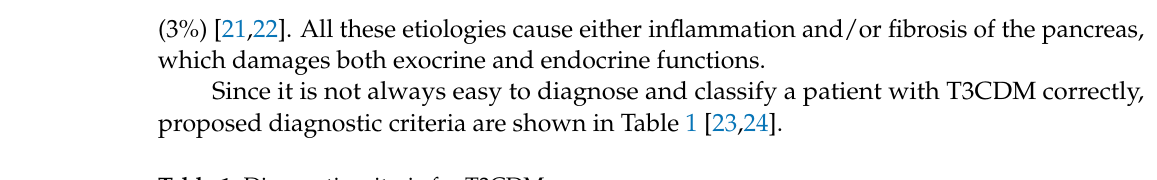
Table 1. Diagnostic criteria for